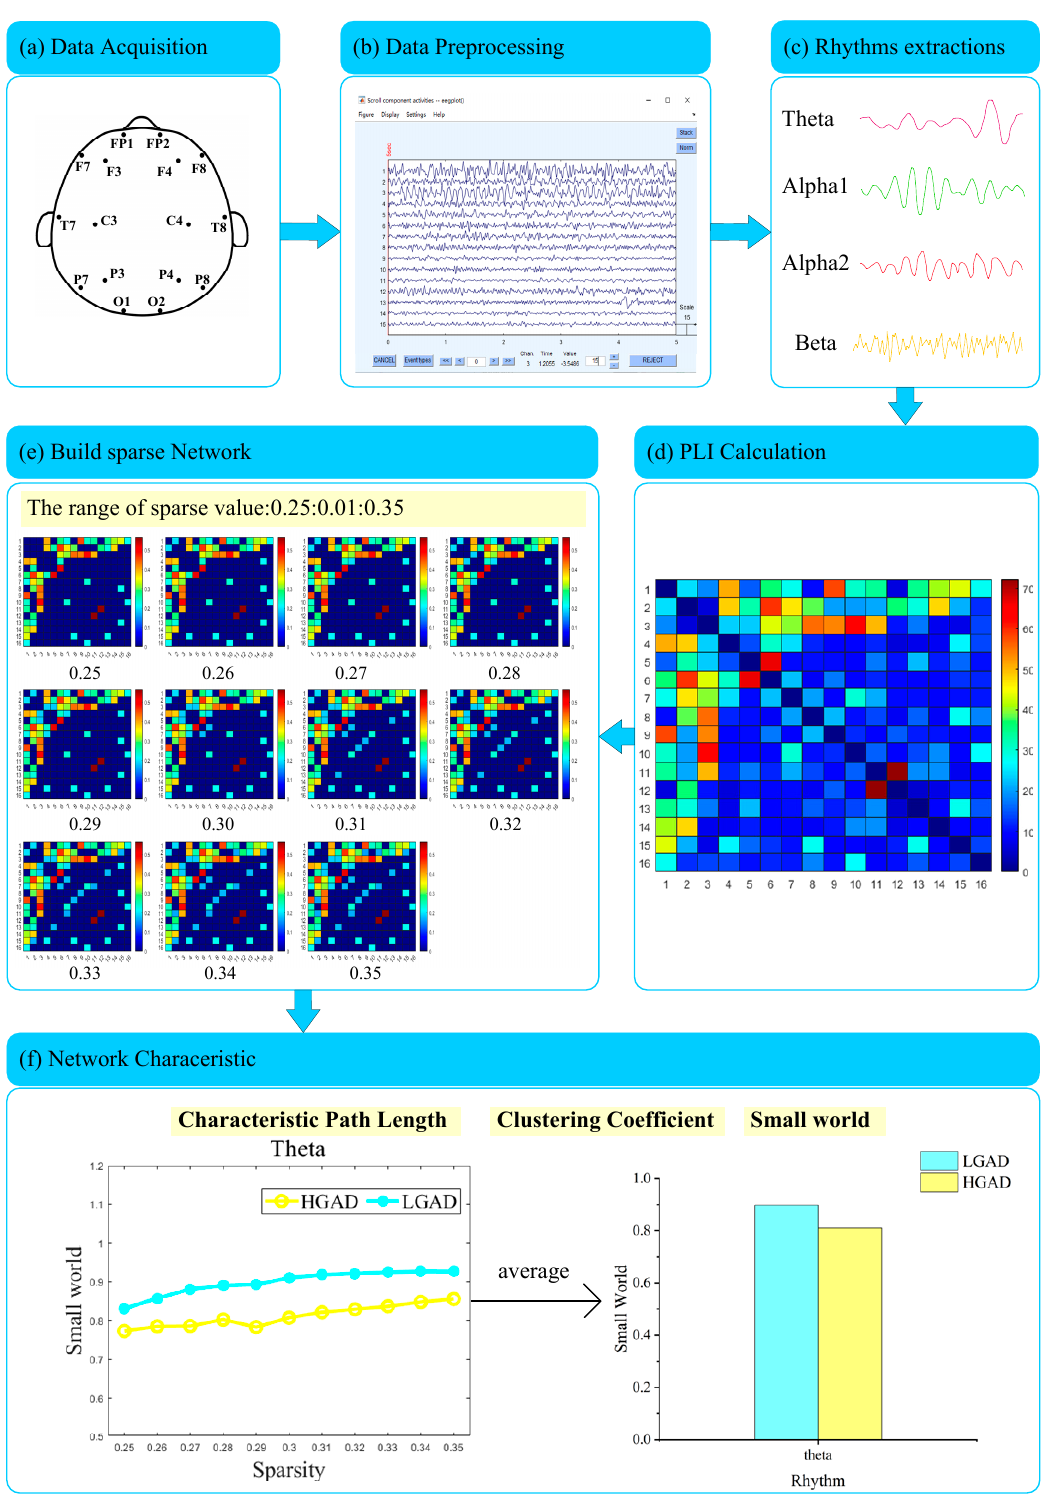
Figure 1. Procedures of data processing. ( a ) EEG data collection with 16 channels. ( b ) EEG data preprocessing without artifacts. ( c ) EEG rhythm extraction. ( d ) Adjacent matrix calculation with PLI values. ( e ) Functional brain network construction with the threshold value from 25% to 35% in 1% steps. ( f ) Network characteristic computations. Each adjacency matrix will obtain 11 values for each network characteristic based on 11 thresholds, which are averaged to form the final network characteristics corresponding to the adjacency matrix.